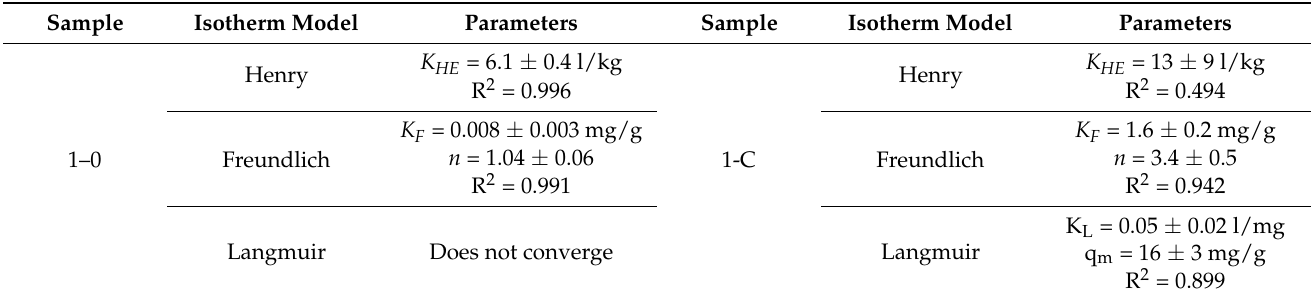
Figure 5. Plot of adsorption capacity (q e ) as a function of equilibrium concentration C e for: ( a ) AgNCs-free filter, blue points and ( b ) AgNCs modified filter, orange points; the isotherm best fit are also shown in the graphs: red line Henry model, green line Freundlich model, and blue line Langmuir model. Table 3. Isotherm parameters determined by fitting the experimental